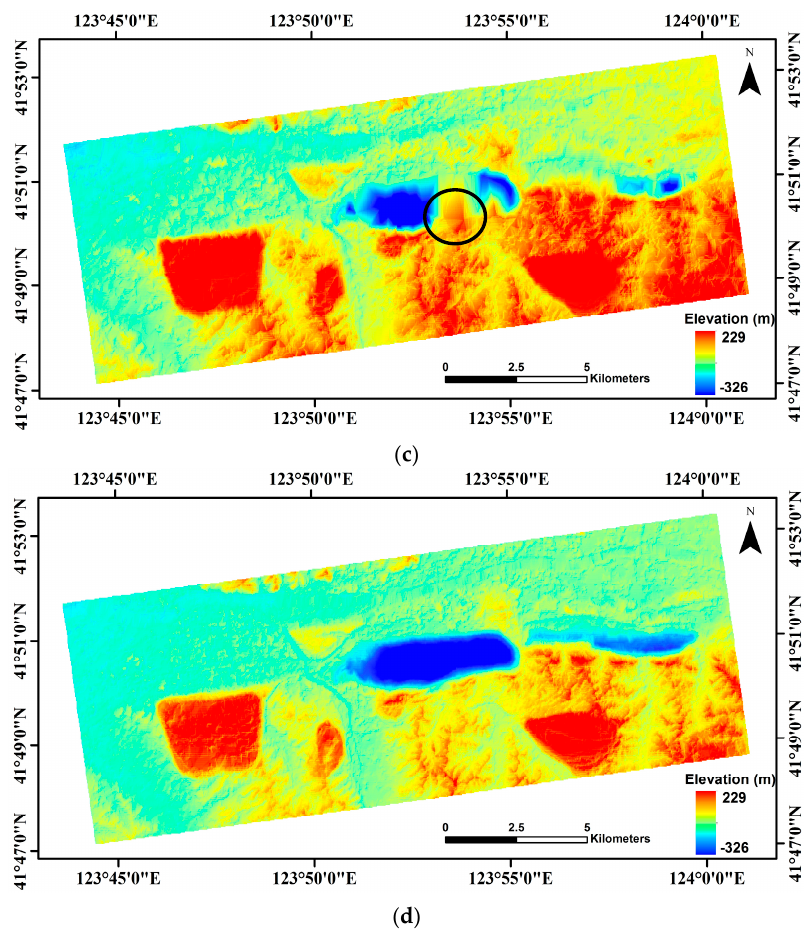
Figure 5. DSMs in the study area. ( a ) ASTER GDEM in July 2010 [40]; ( b ) ZY-3 DSM on 24 December 2013; ( c ) ZY-3 DSM on 21 April 2014 (the black circle indicates an area of high elevation not real). ( d ) ZY-3 DSM on 24 October 2015. Table 2. Results of multi-temporal DSMs in the study area.